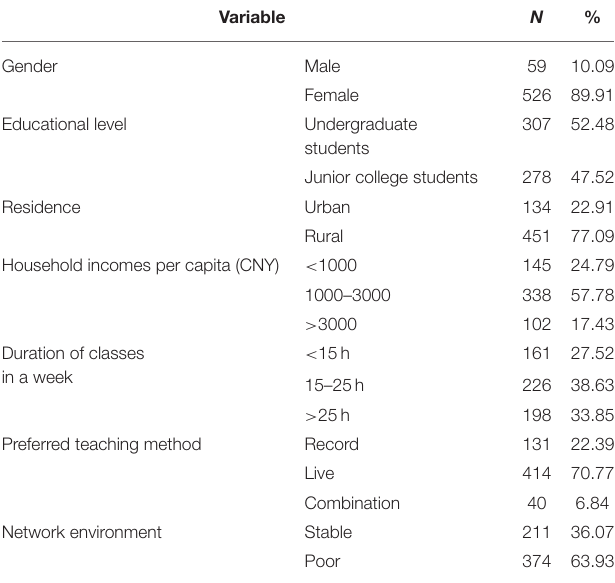
TABLE 1 | Sociodemographic characteristics of the study participants ( N =